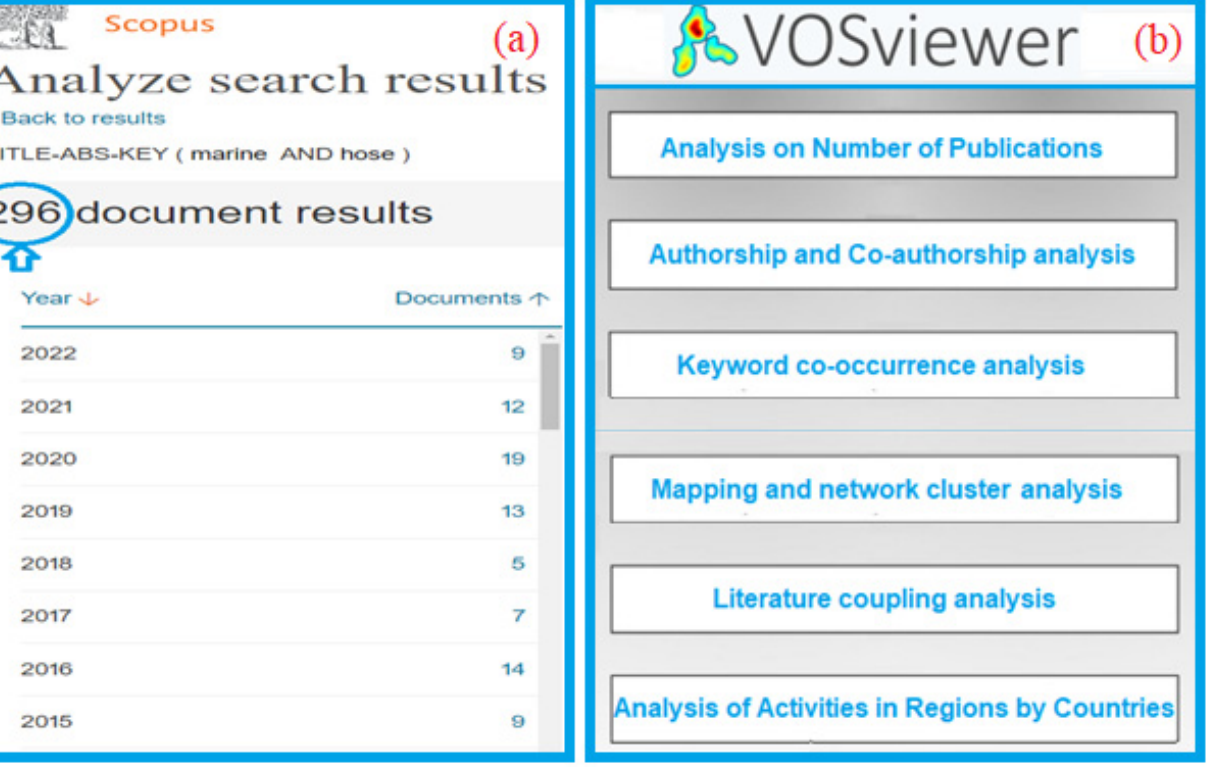
Figure 3. Image showing ( a ) the interface of the Scopus database used for the data analysis on “ma- rine hose” and ( b ) the VOSviewer interface with some areas that can be